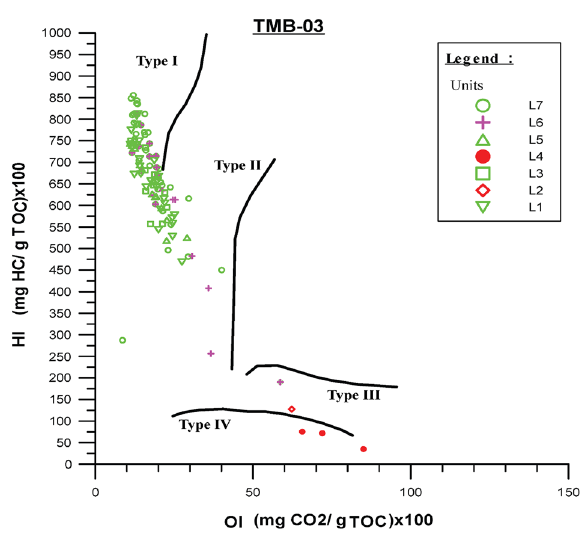
Fig. 6 van Krevelen diagram showing the different types of organic matter for the studied